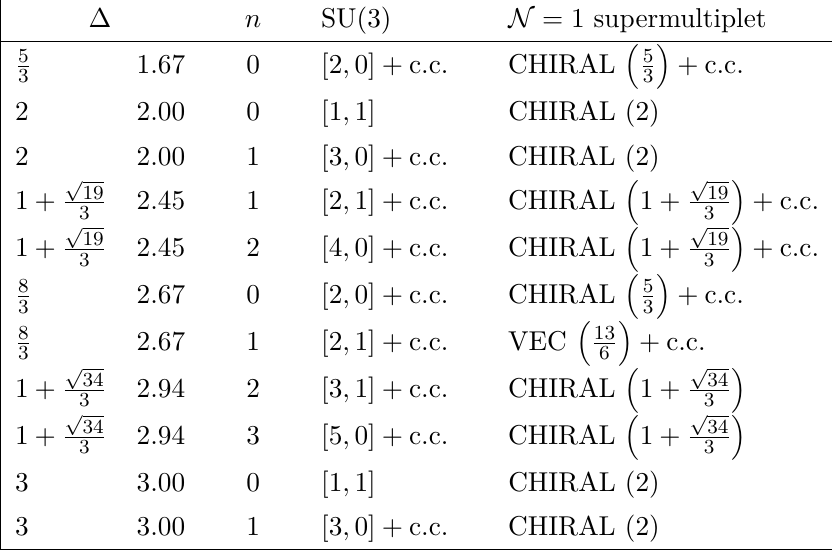
Table 16 . All KK scalars with dimension ∆ ≤ 3 around the N = 1 SU(3)-invariant AdS 4 solution of type